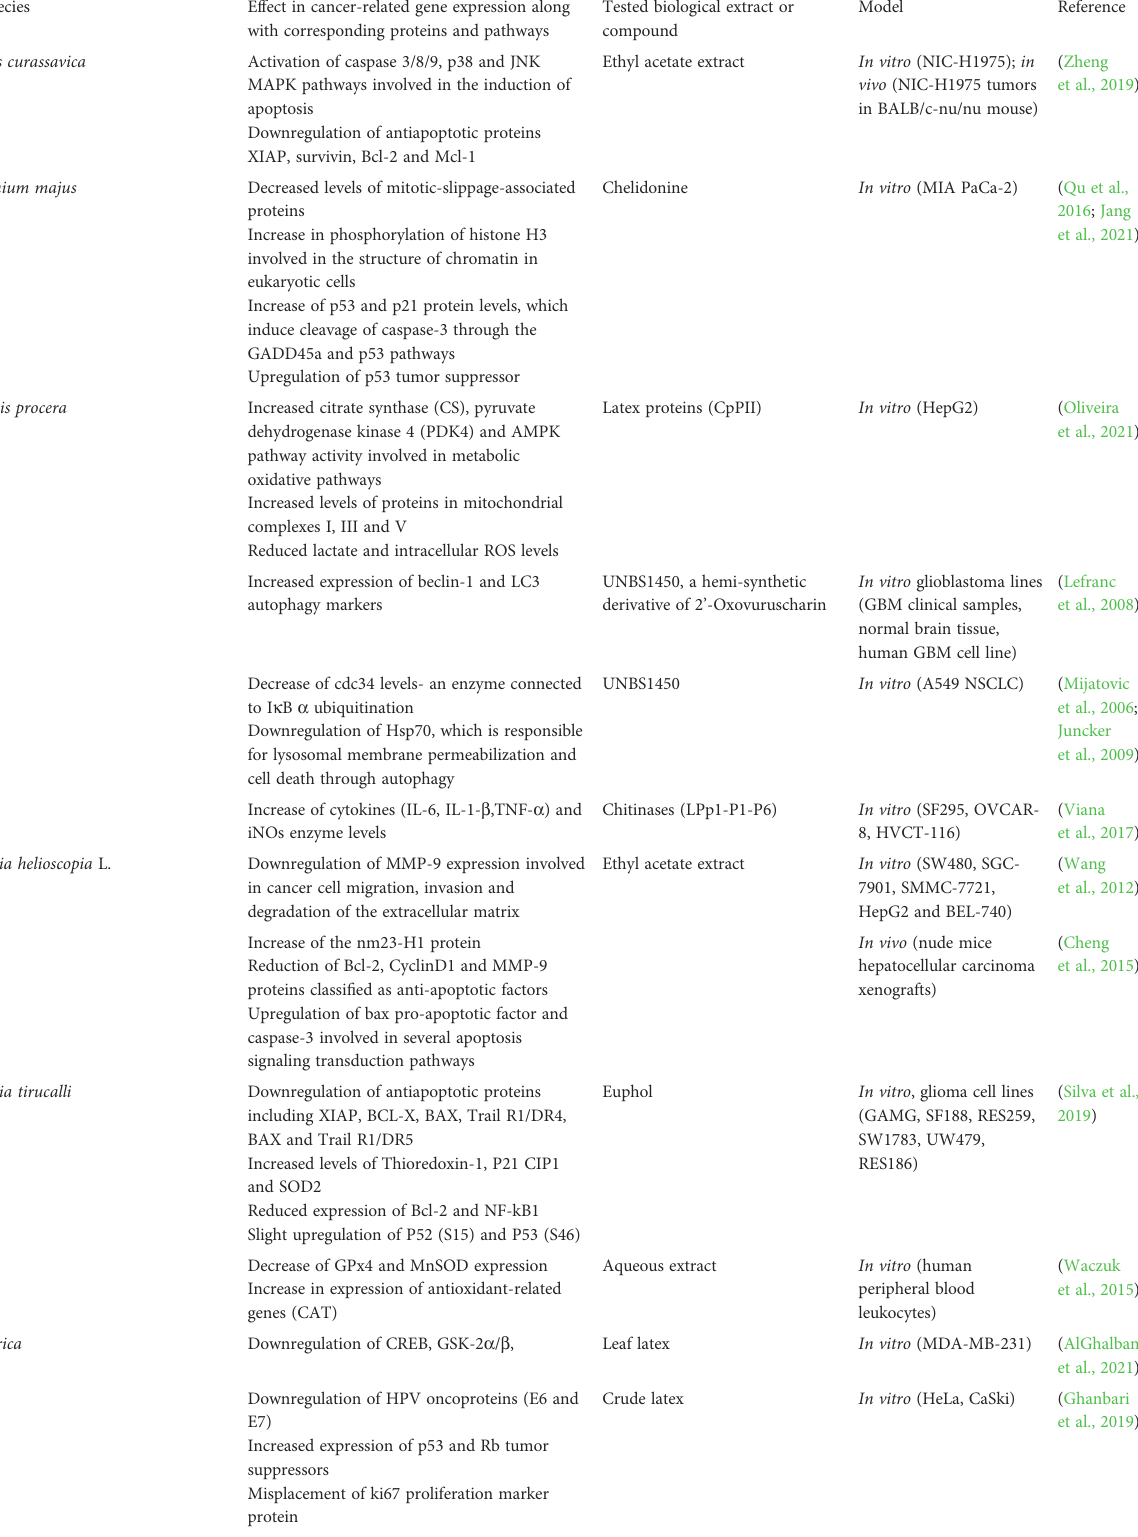
TABLE 3 Changes in expression patterns of cancer-related genes post administration of plant latex extracts or its compounds in vitro or in vivo. Plant